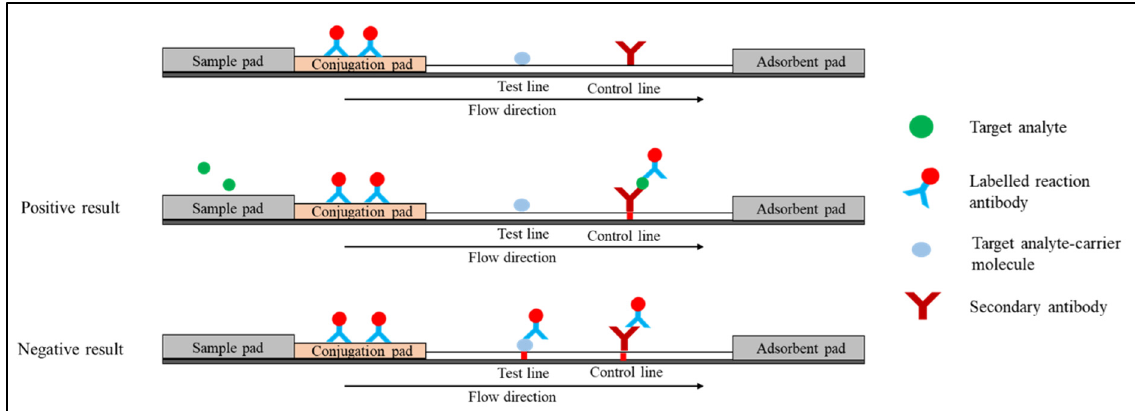
Figure 3. Schematic diagram shows the competitive format (first arrangement).